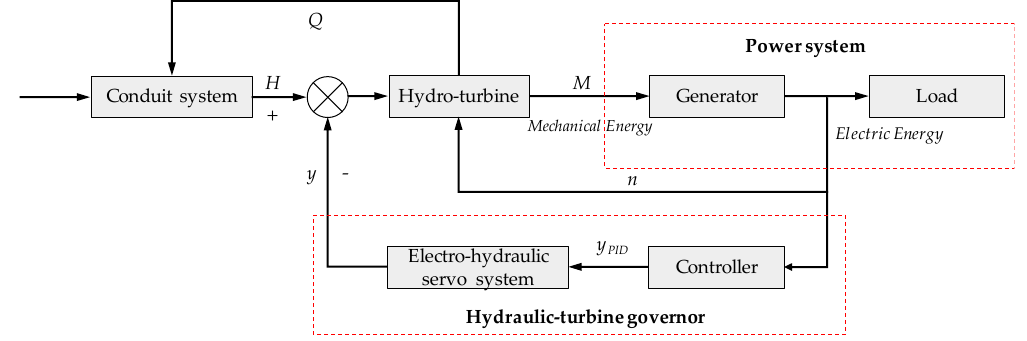
Figure 1. Structure of small hydropower station turbine governing system.